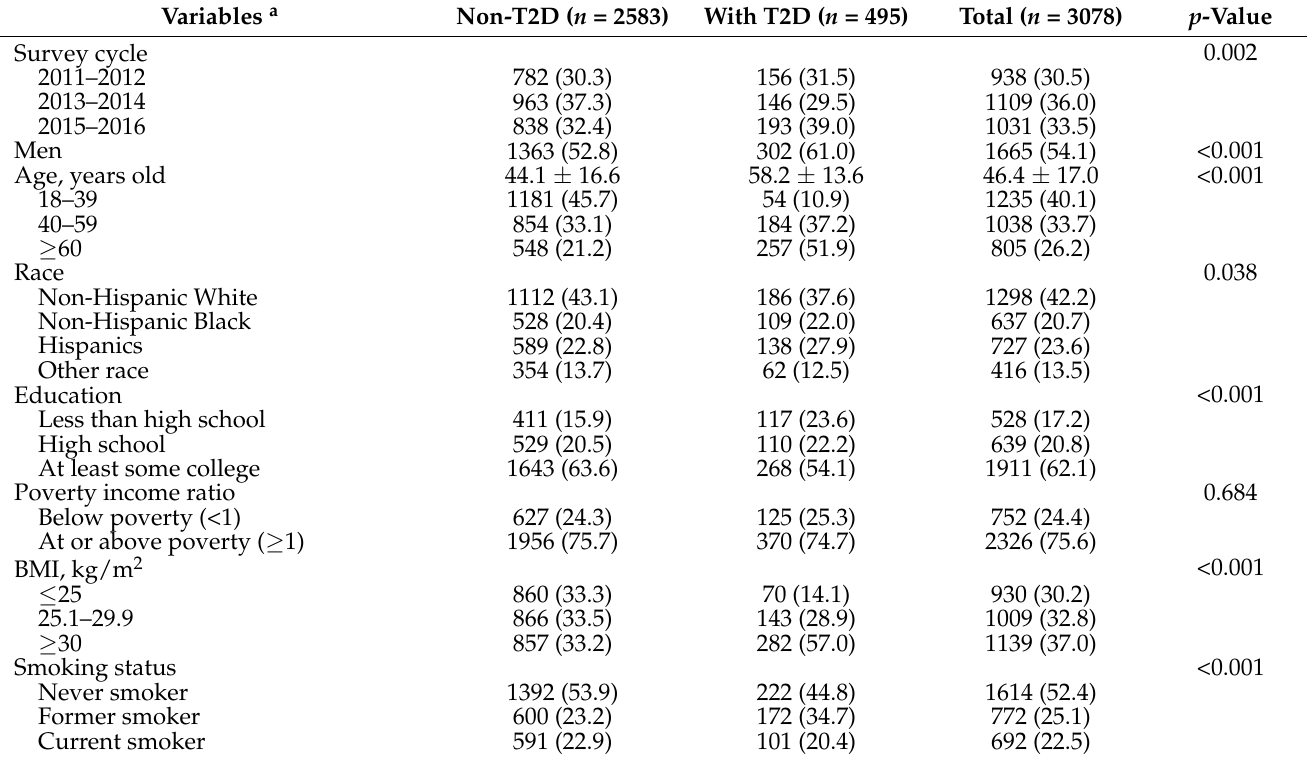
Table 1. Basic characteristics of participants by type 2 diabetes (T2D) in NHANES